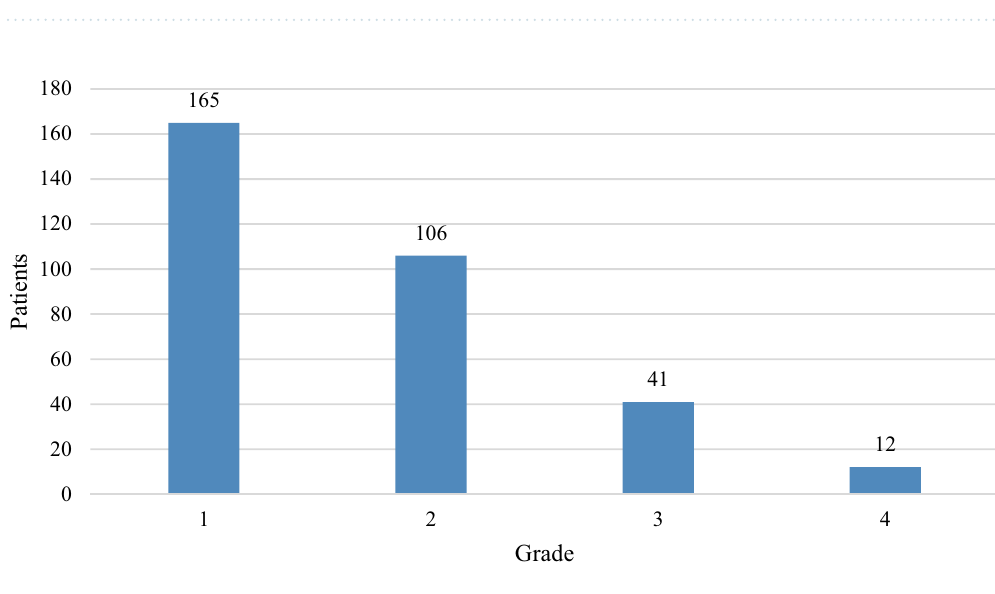
Table 1. Clinical characteristics based on patients.